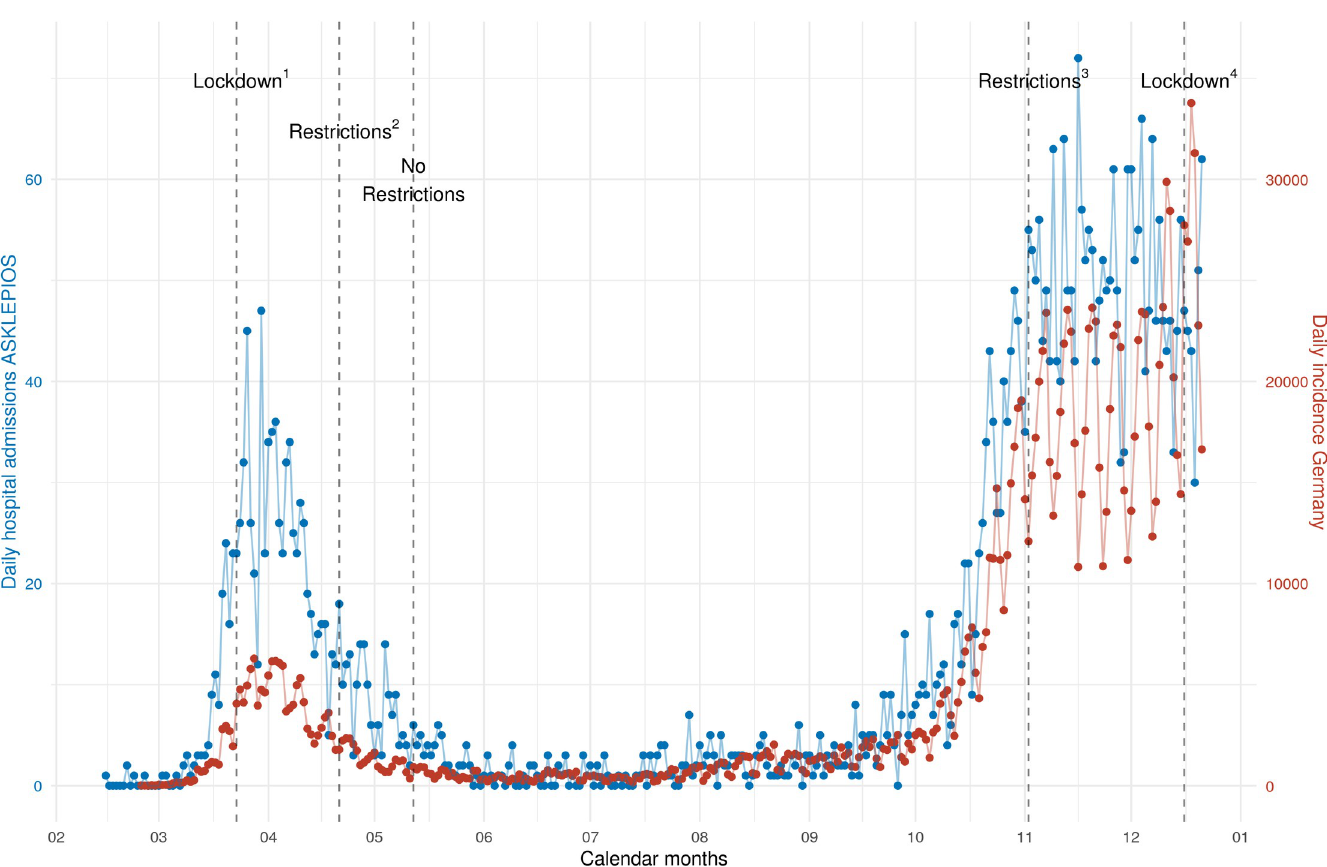
Fig 3. Daily admissions of COVID-19 patients to the participating 45 centers in 2020 (blue color) and daily incidence of Germany in 2020 (red color, data used with kind approval by RKI, [13]). 1 Lockdown: Closing of restaurants, most shops, schools, kindergardens, etc.; 2 Restrictions: First openings of shops (with restrictions), partial opening of schools, restaurants remained closed; 3 Restrictions: Closing of restaurants, hairdressing salons, etc.; 4 Lockdown: Additionally, closing of schools, kindergardens, several shops, etc.